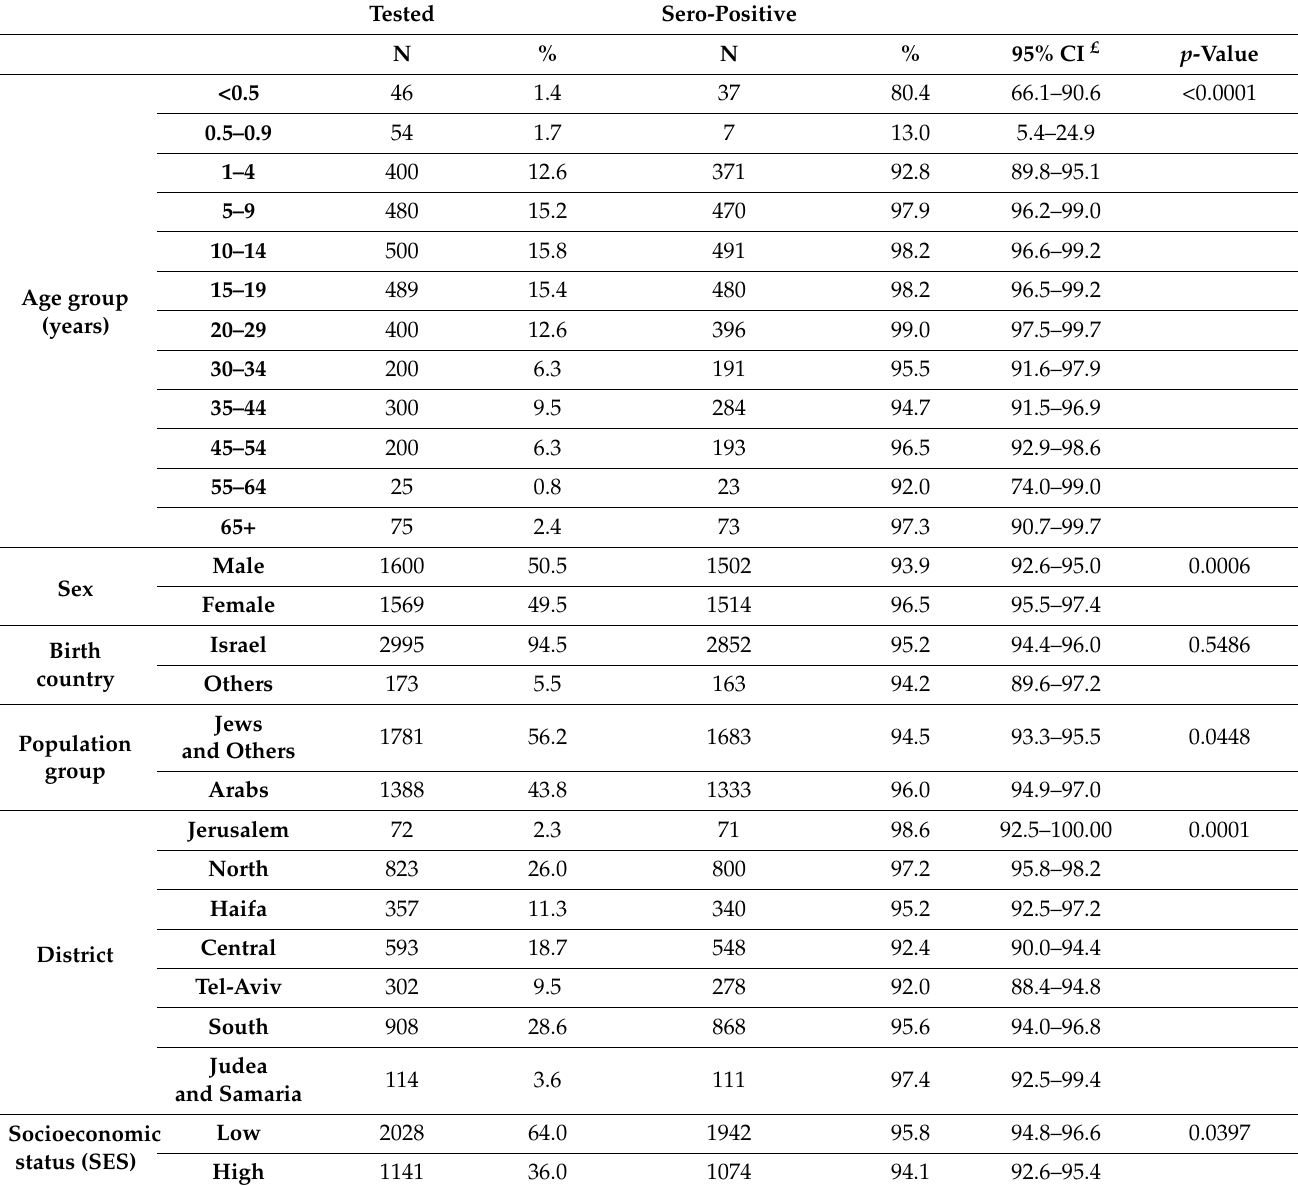
Table 3. Sero-positivity for rubella IgG antibodies by demographic characteristics in Israel, 2015 ( n =